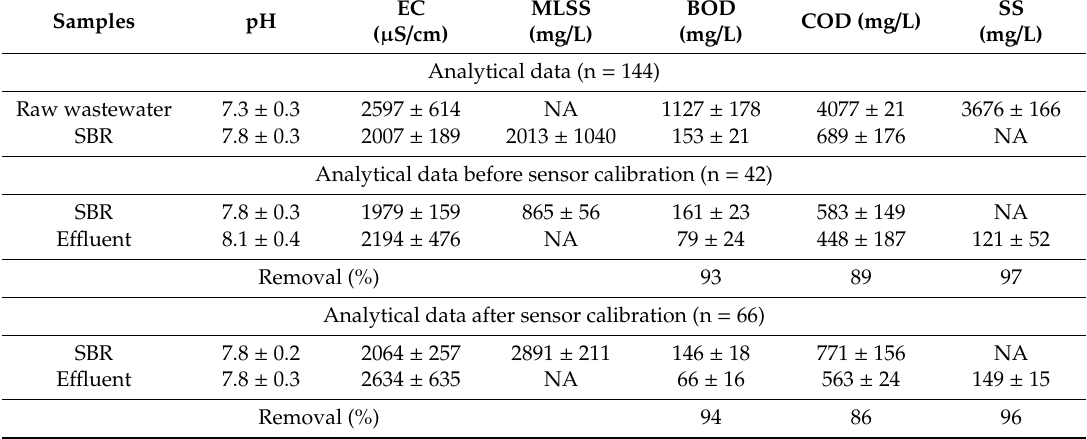
Table 7. Removal e ffi ciency of BOD, COD, and SS of the piggery wastewater based on the analytical data. Samples